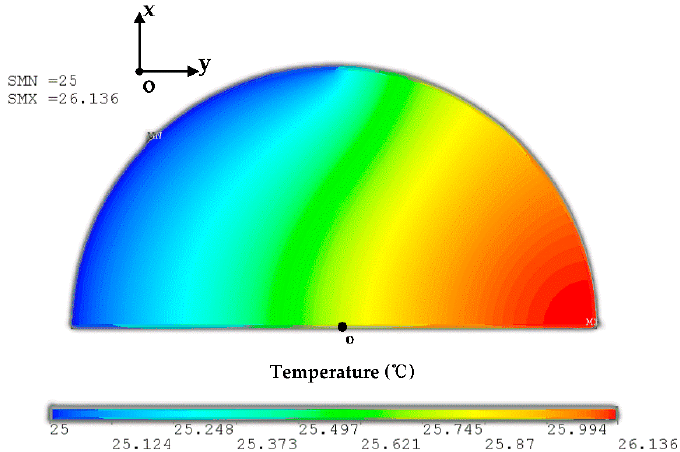
Figure 11. The temperature profile of the laser rod in each pump and heat-removal structure.